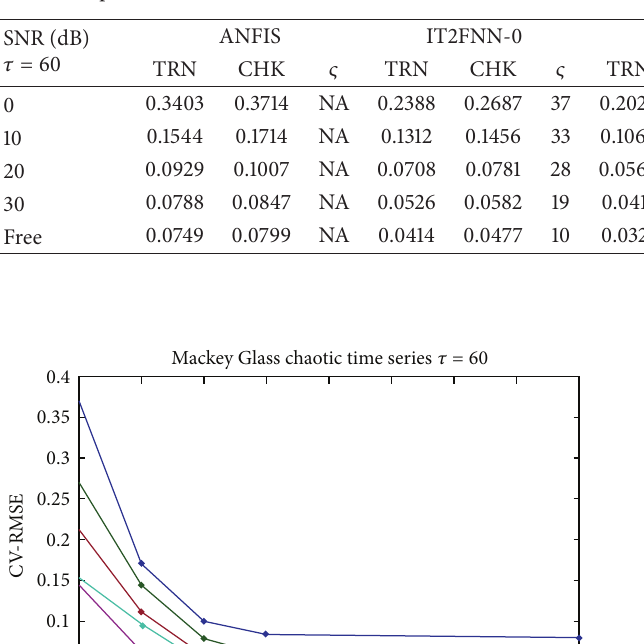
Table 3: RMSE (TRN/CHK) and 𝜍 values determined by ANFIS and IT2FNN models with 10 fold cross-validation for Mackey-Glass chaotic time series prediction with 𝜏 = 60 .